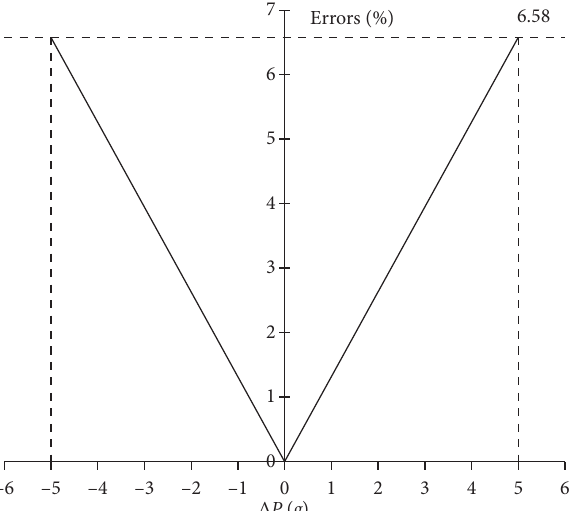
Figure 5: Errors caused by variation of cone weight P .